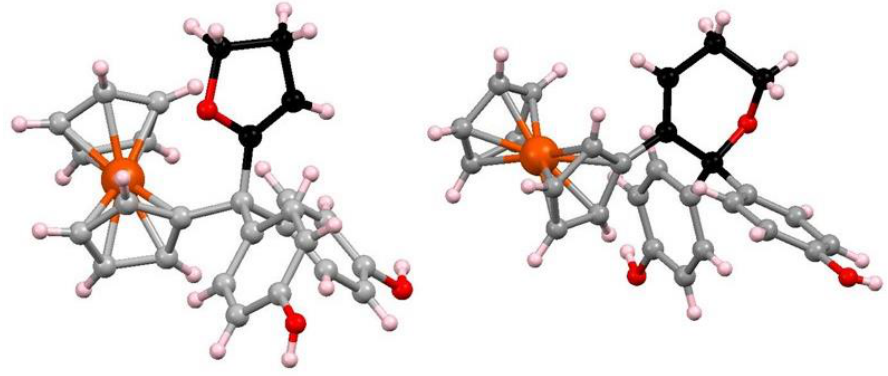
Figure 5. Molecular structures of (left) dihydrofuran, 105 , and (right) dihydropyran, 106 .